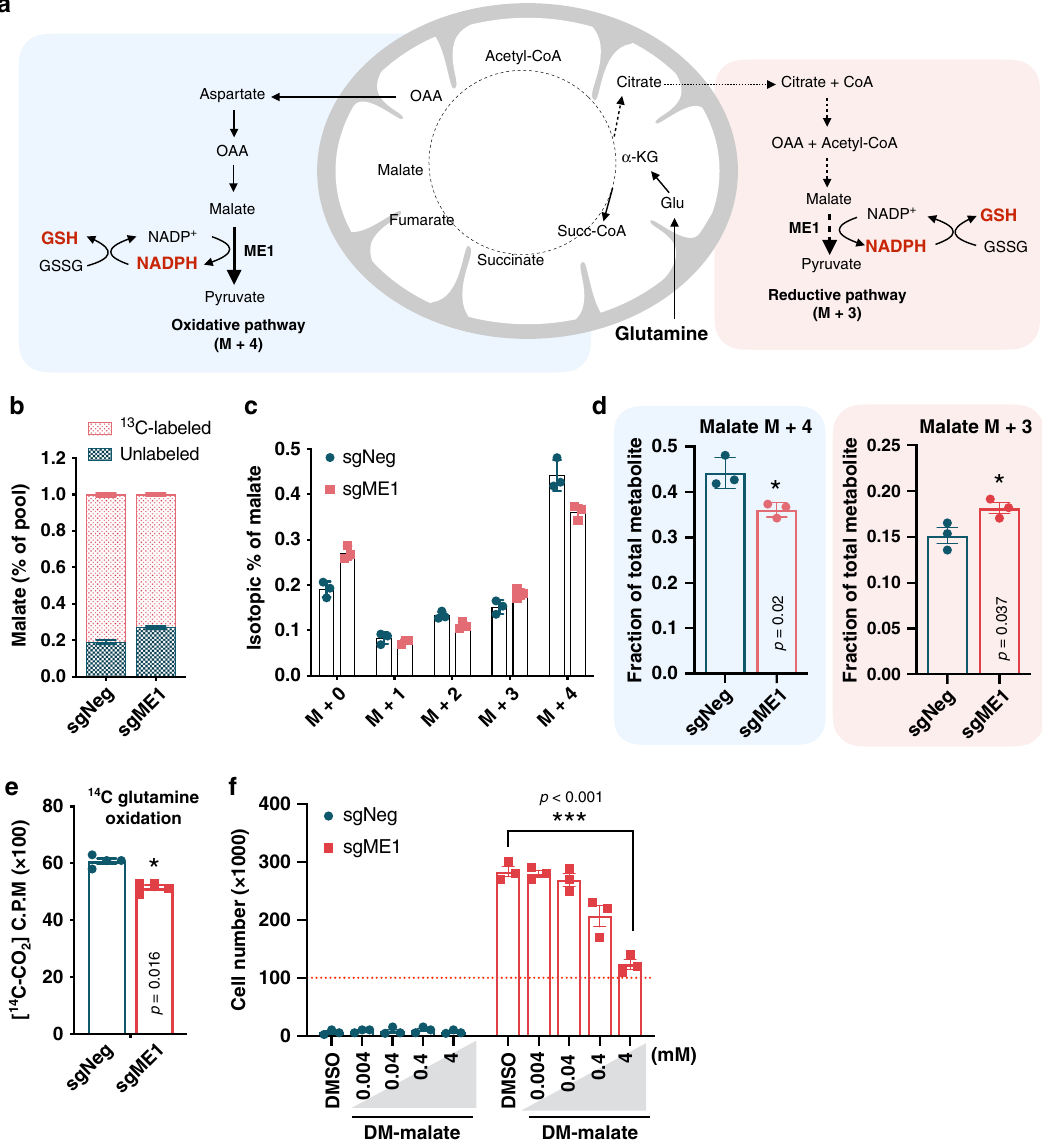
Fig. 2 ME1 induction promotes reductive carboxylation of glutamine. a Model illustrating the fate of fully labeled 13 C glutamine after entering the TCA cycle. Glutamine oxidation generates M + 4 labeled substrates while its reductive carboxylation generates M + 3 labeled substrates. Note that ME1 activity is coupled to NADPH production and reduction of oxidized glutathione. b Percentage of labeled and unlabeled malate in ND1 mutant cells after 3 h incubation with 13 C-labeled ([U- 13 C 5 ]) glutamine ( n = 3). c Isotopomer distribution of malate in sgNeg and sgME1 ND1 mutant cells cultured in the presence of 13 C glutamine for 3 h ( n = 3). d ME1 overexpression decreases malate M + 4 originated by oxidation of glutamine in the TCA cycle and increases malate M + 3 coming from reductive carboxylation of glutamine ( n = 3). e 14 C glutamine oxidation is reduced in ND1 mutant cells overexpressing ME1 (n = 3). f Supplementation of cell permeable dimethyl-malate (DM-malate), at the indicated doses, did not increase survival of ND1 under galactose conditions ( n = 3). Experiments are represented as means ± SEM., n > 3 biological replicates. Asterisks denote * p < 0.05, ** p < 0.01, or *** p < 0.001. Paired two-tailed Student ’ s t test in d , e and one-way ANOVA in f . Red dashed lines indicate initial seeding